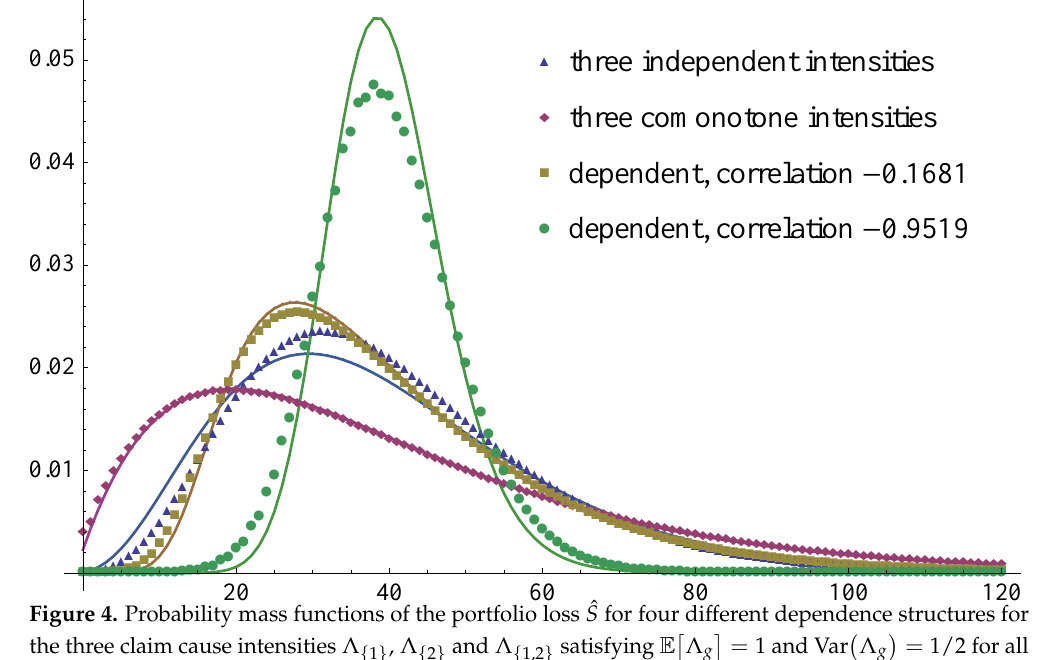
(cid:2) Λ (cid:3) = (cid:0) Λ (cid:1) = 1 and Var 1/2 for all g g = X s = δ X s = δ 2 . The given correlation 1 and { 1 } { 2 } { 1,2 }